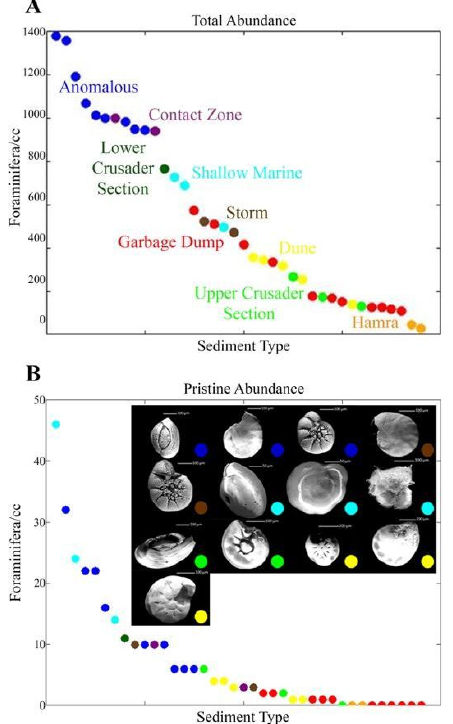
Figure 7. Foraminiferal abundances of all samples collected. ( A ) Total and ( B ) Pristine abundances of both core and reference samples of foraminifera per cubic centimeter of sediment. Refer to Figure 1 for sample collection